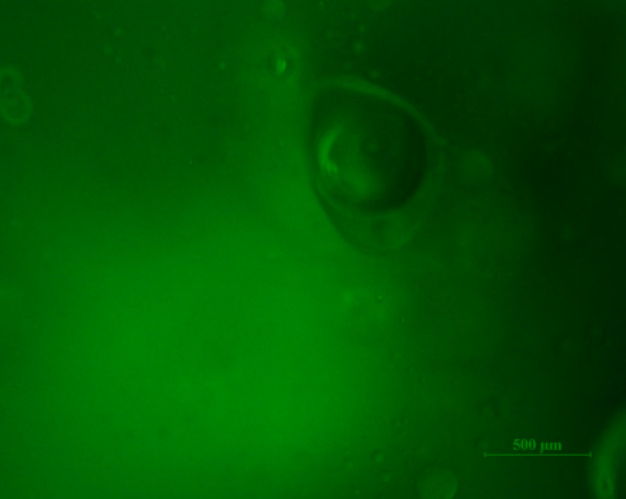
Figure 6. Fluorescence microscope image of polyphosphazene hydrogel immobilized with FITC-BSA (the scale bar is 500 μ